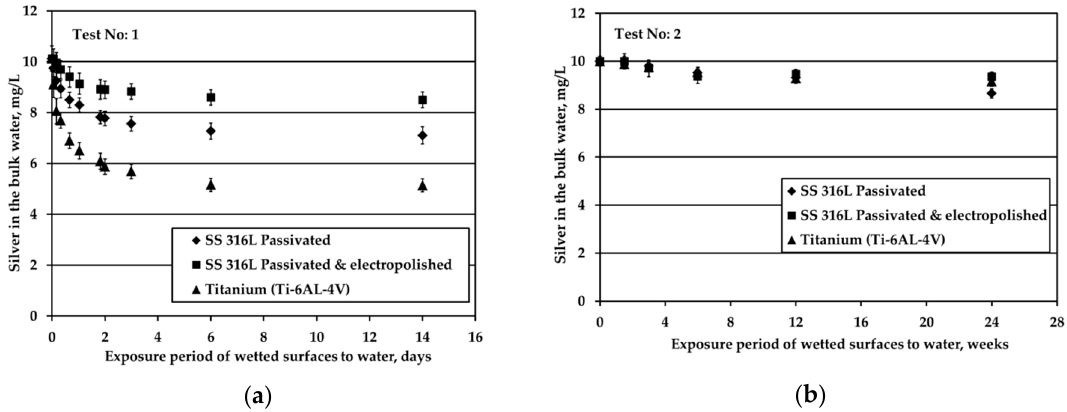
Figure 1. Silver loss from the bulk water (initial Ag concentration: 10 mg / L) for all three examined materials under nitrogen headspace and stagnant conditions for S / V equal to ( a ) 1.0 cm − 1 and ( b ) 0.1 cm − 1 .